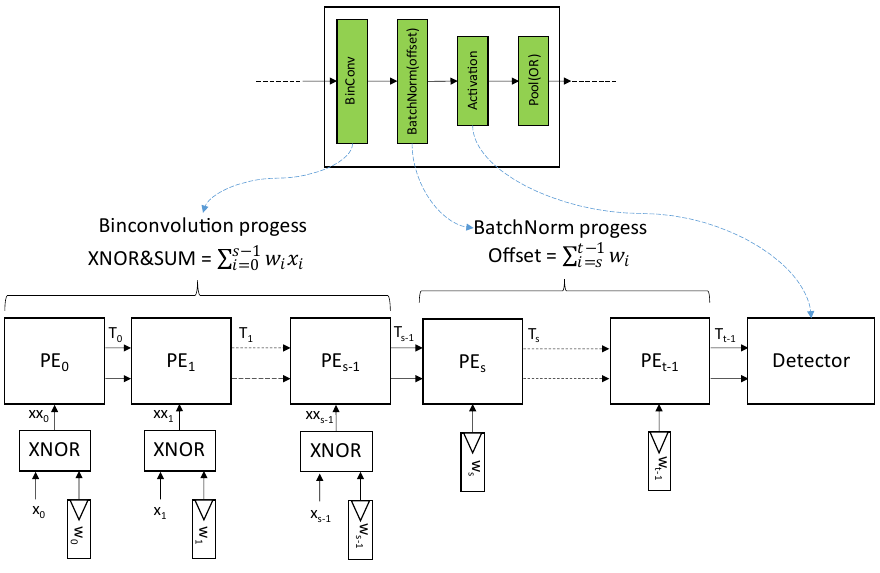
Figure 8. The process of joint design. As shown in Figure 8, after the binary convolution array, we set up some time-domain PEs to complete the batch normalization process. Unlike the previous method, the input value of these PEs is directly preconfigured with the corresponding w i value through the As shown in Figure 9a,b, the intermediate results of traditional CNN are real values throughout the process. The input activation of convolution in BinaryNet [6] is binary, while the outputs of convolution are integer values. Thus, traditional BNN deals with integer values during the pooling operation and batch normalization operation.